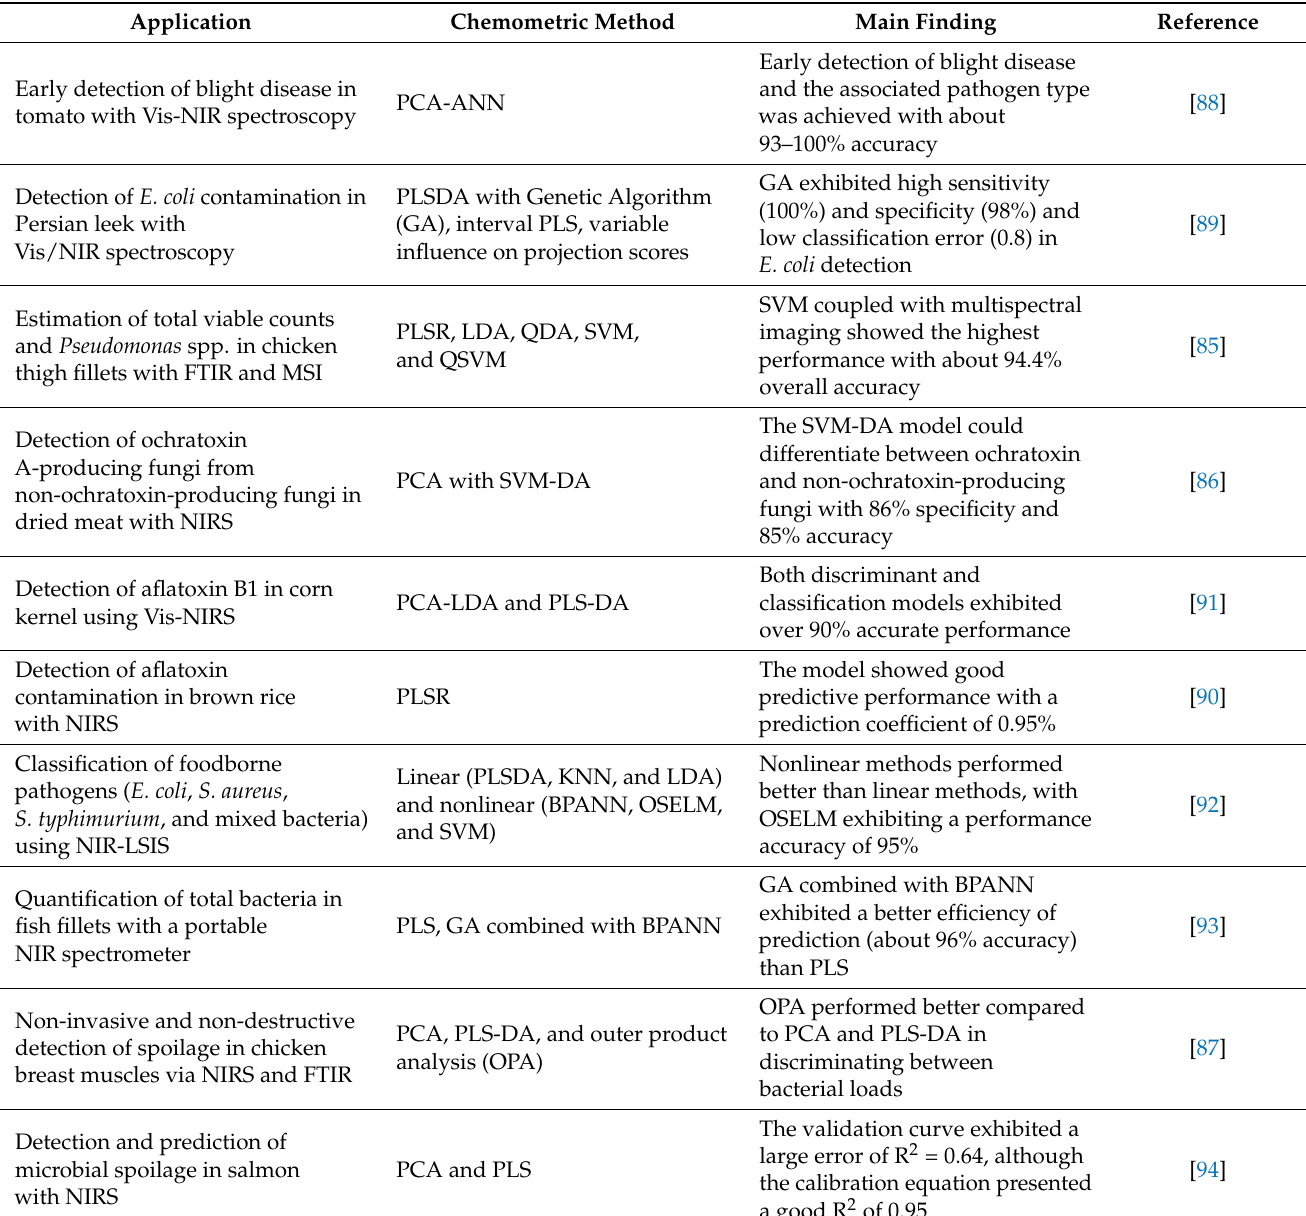
Table 1. Some applications of NIRS in combination with chemometrics for microbial